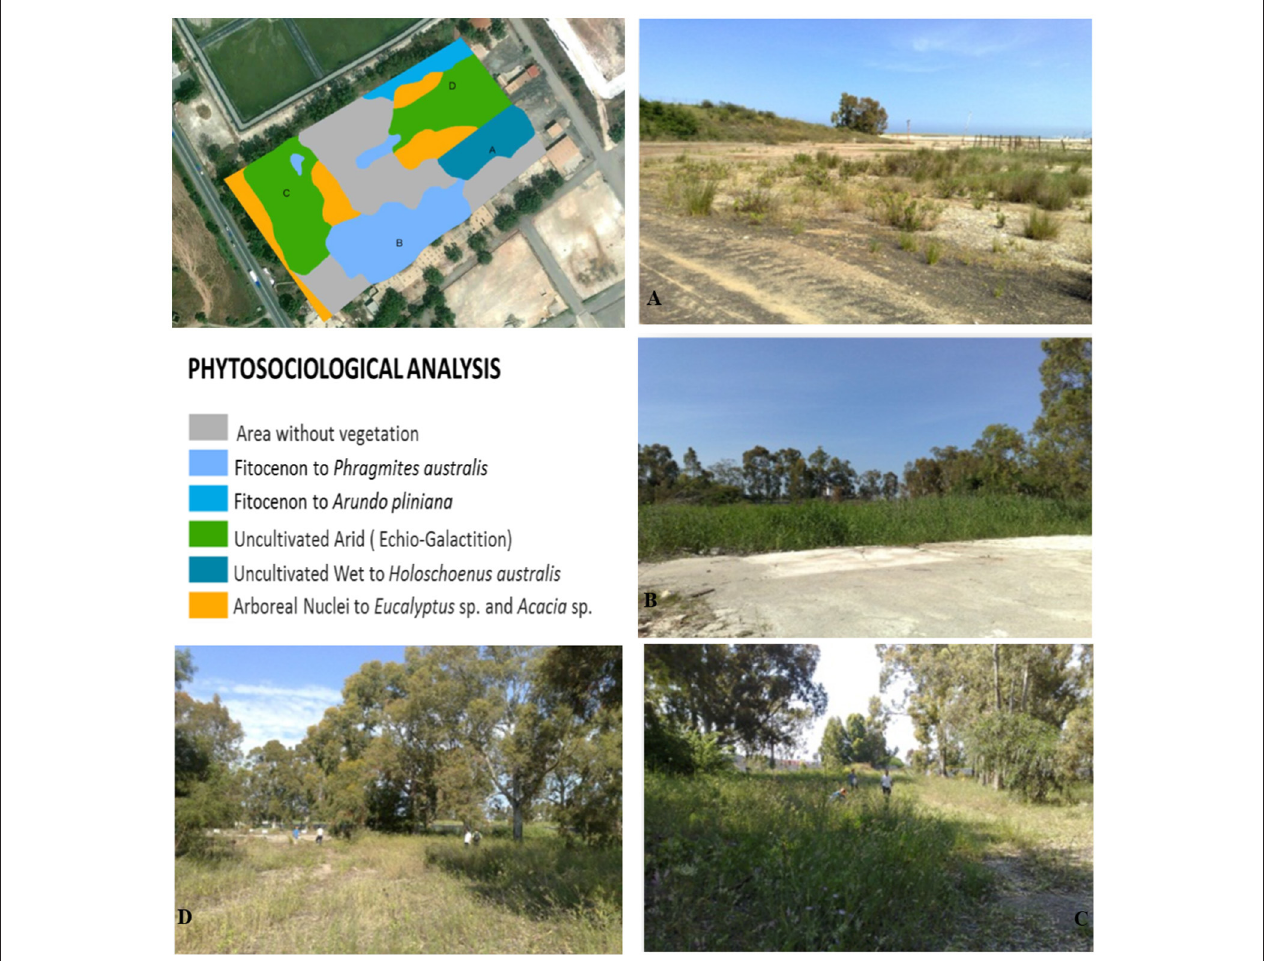
FIGURE 1 | The phytosociologiacal analysis of the SIN (Site of National Interest) named “Crotone-Casssano-Cerchiara” of south Italy. (A) Uncultivated arid, (B) Fitocenon to Phragmites australis , (C) Fitocenon to, (D) Arboreal Nuclei to Eucalyptus sp.and Acacia